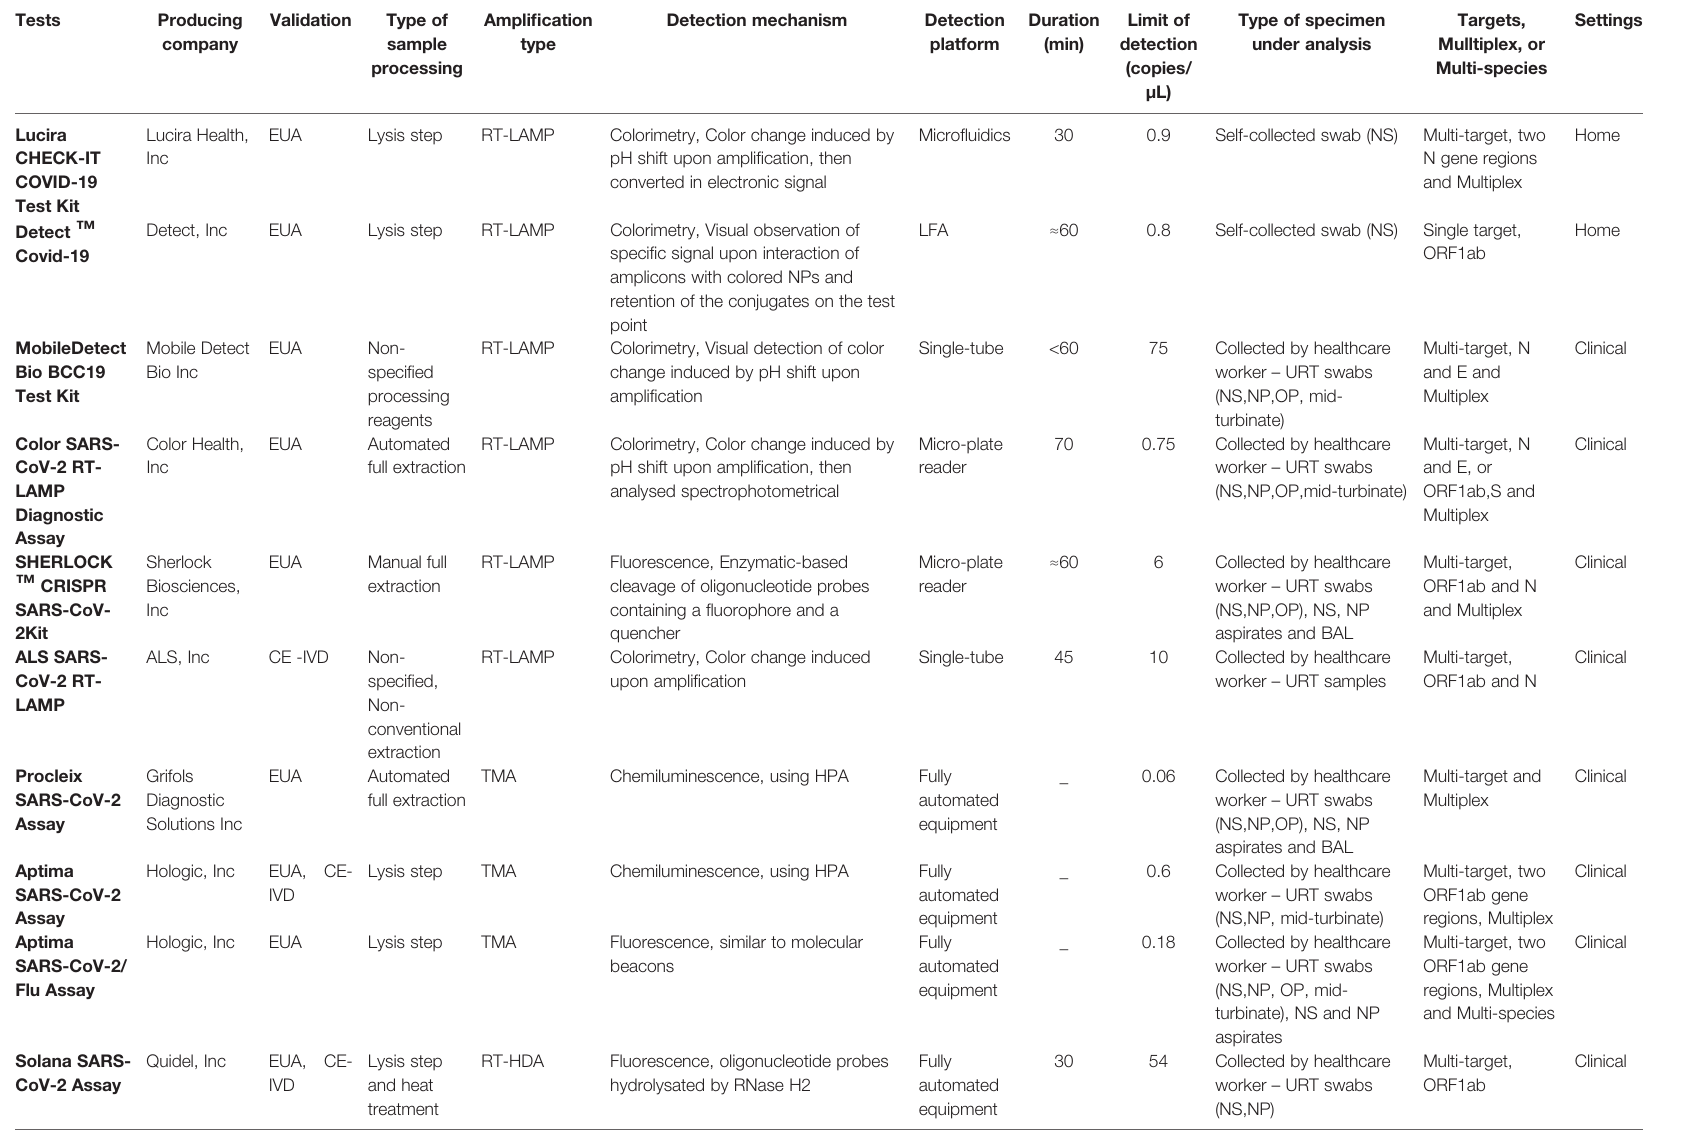
TABLE 9 | Benchmarking of diagnostics for SARS-CoV-2 based on Isothermal ampli fi cation-derived methods issued with EUA, or CE